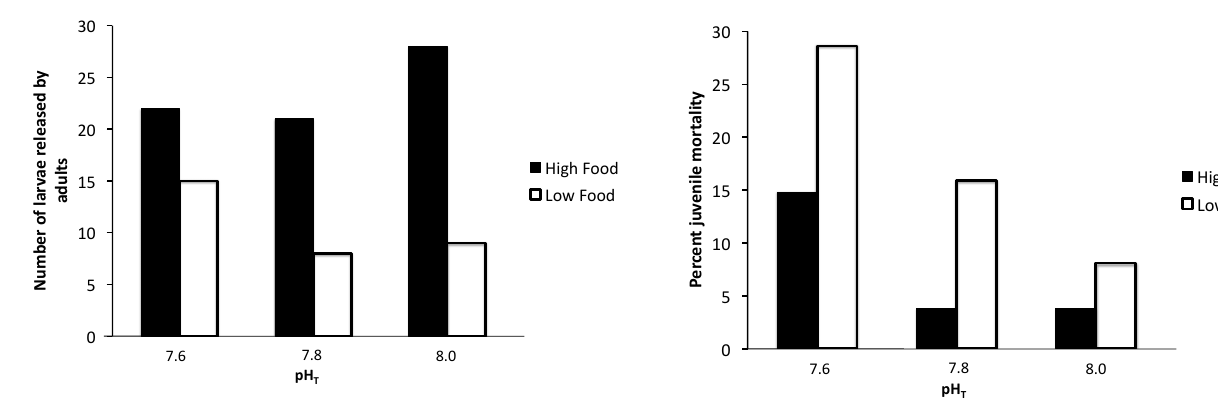
Fig. 2. Numbers of planula larvae released by 10 Balanophyllia el- egans adults over 3 months in each pH T X food treatment. Fig. 3. Percent mortality of juvenile Balanophyllia elegans over 84days in each pH T X food treatment. Initial numbers varied from 26 to 44 for a total of 202